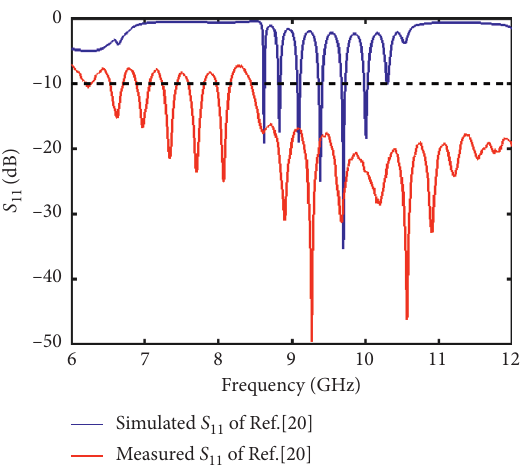
Figure 20: The S -parameter of the antenna of [20] and the proposed periodic MLWA antenna.